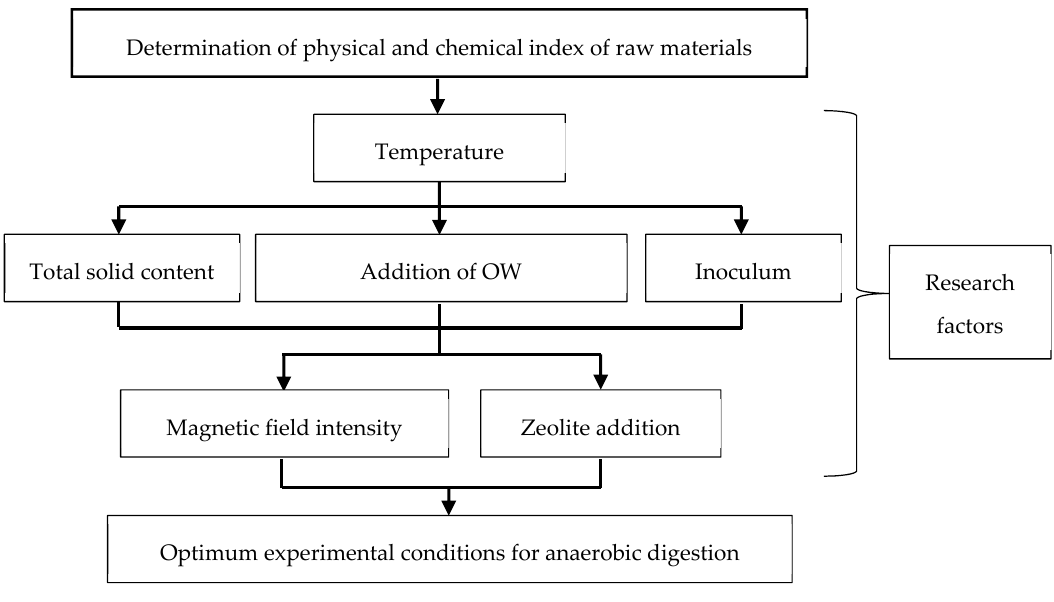
Figure 2. Flow chart of the experiment. Table 2. Experimental conditions under di ff erent research factors. DW: distilled water; OW: organic wastewater; VFAs: volatile fatty